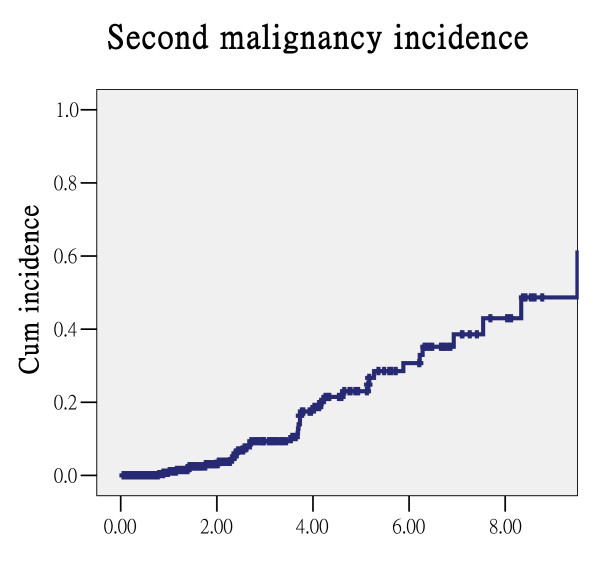
Cumulative incidence of second malignancy.